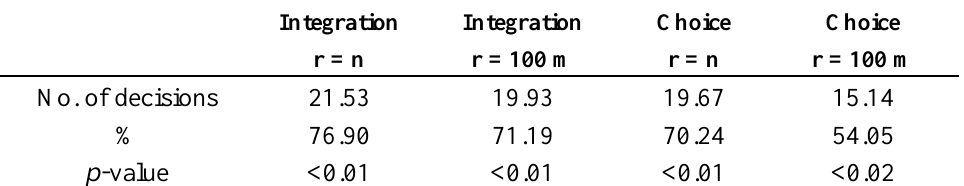
Table 1. Decisions made independent of